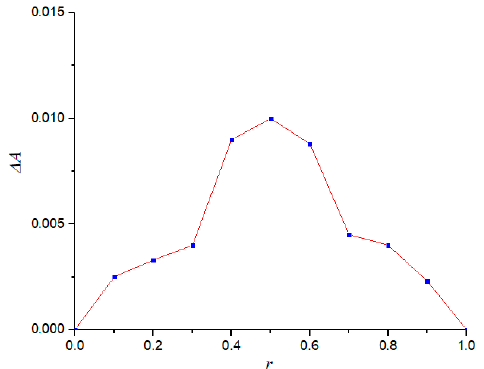
Figure 7. Inclusion ratio study.